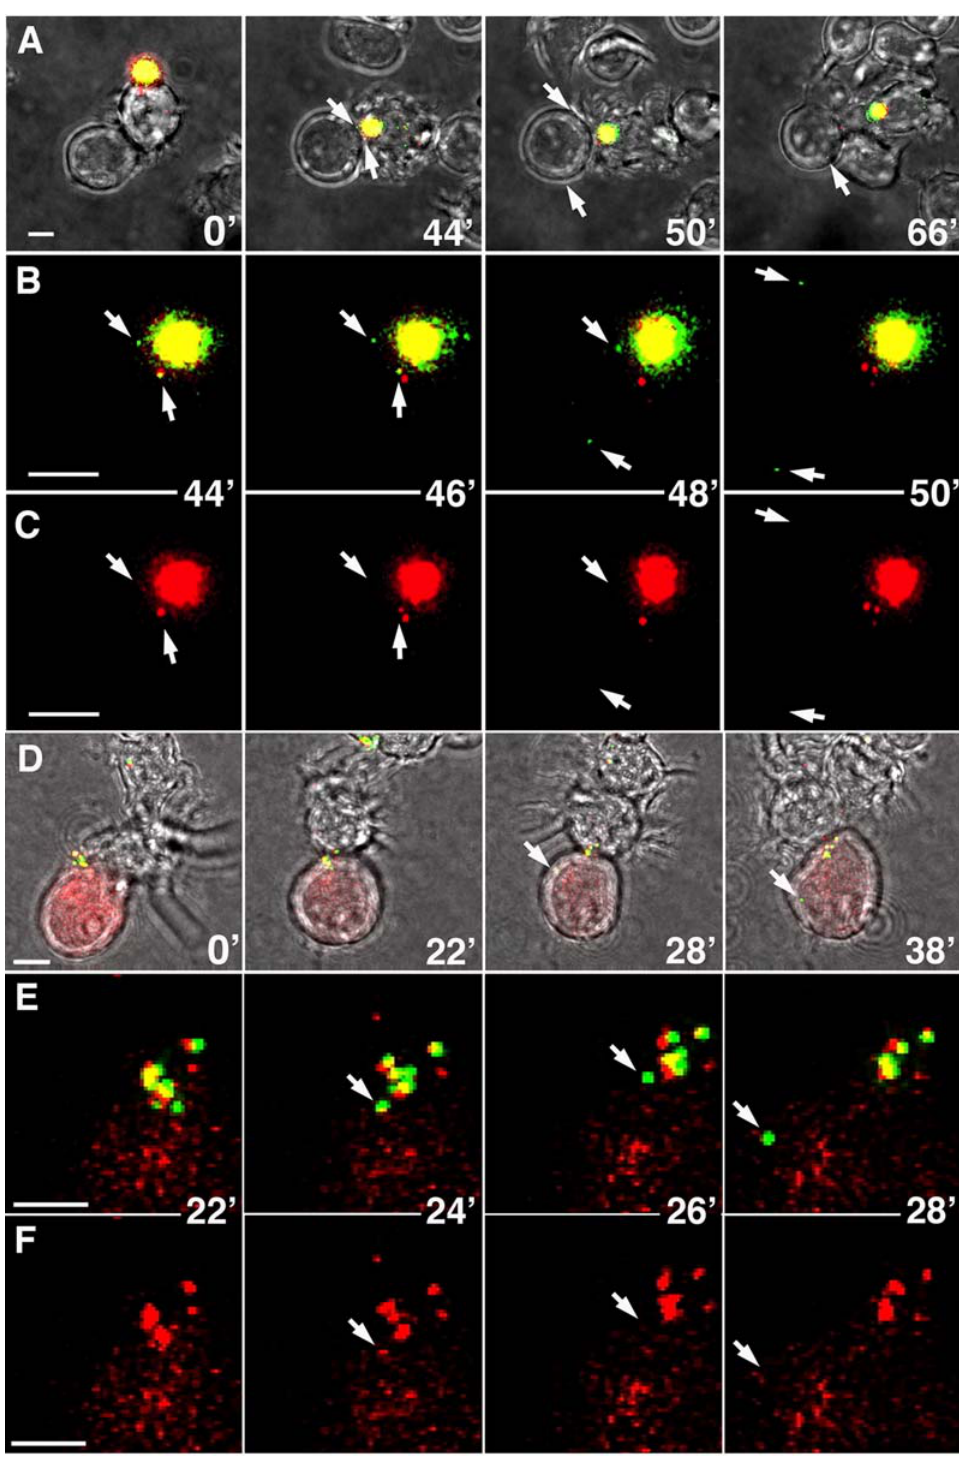
Figure 4. DCs transmit individual HIV particles to T cells at the infectious synapse. (A–C) Mature MDDCs were incubated with GFP-Vpr/ S15-RFP labeled HIV for 1 h at 37 u C, washed, and plated onto a glass coverslip dish. GFP-Vpr (green) marks the HIV core, and S15-RFP (red) is a myristoylated fusion that marks the viral membrane prior to T cell entry. Jurkat LTR-GFP T cells were added and cells were imaged at 2-min intervals immediately after identifying DC–T cell interaction. (A) Merged fluorescent and light images of key time-points during the DC–T cell interaction. Arrows denote viral transmission events. (B,C) Magnified view of GFP/RFP (B) and RFP (C) signals at time points immediately before and during transmission of HIV particles. Arrows denote individual particles transmitted into the T cell. (D–F) Mature myeloid DCs were incubated with labeled HIV as in (A) and plated onto a glass coverslip dish. Jurkat T cells labeled with CellTrace DDAO-SE (diffuse red signal) were added and cells were imaged every 2 min as above. (E,F) Magnified view of GFP/RFP (E) and RFP (F) signals at time-points immediately before and during transmission of HIV particles. Bars, 5 m (A, D); 2 m (B, C, E, F). See also Videos S1 and S2. doi:10.1371/journal.ppat.1000134.g004 PLoS Pathogens |